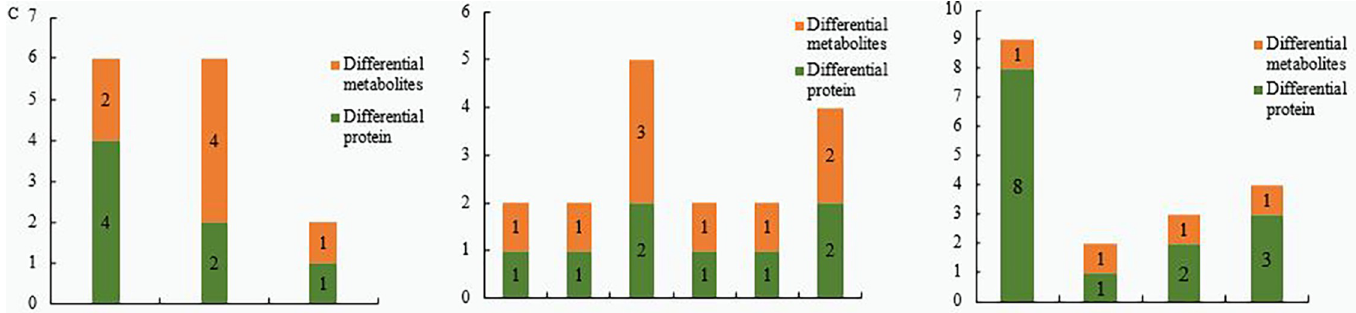
Fig 10. Metabolic pathways involving differential proteins and metabolites in Z_VS_ C group. Note: A: Metabolic pathways involving differential proteins and metabolites in ZA_VS_ CK; B: Metabolic pathways involving differential proteins and metabolites in ZB_VS_ CK; C: Metabolic pathways involving differential proteins and metabolites in ZC_VS_